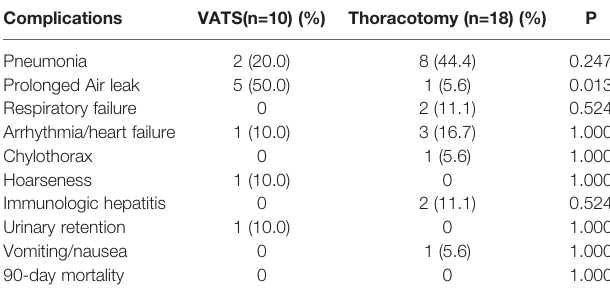
TABLE 2 | Postoperative complications within 30 days and 90-day morbidity in different surgical